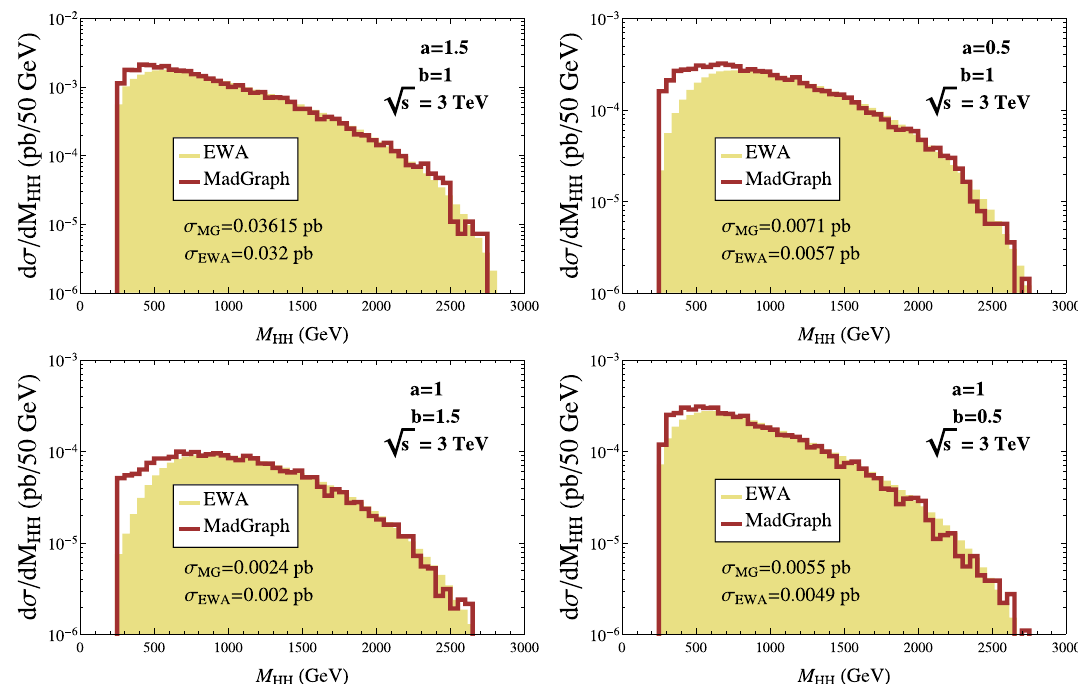
Fig. 19 Predictions of the cross section distributions for e + e − → H H ν e ¯ ν e with respect to the Higgs pair invariant mass, M HH , within the EChL, for different values of the parameters a and b . The collider energy is set to 3 TeV. The results from both MG5 and the EWA computations are shown for